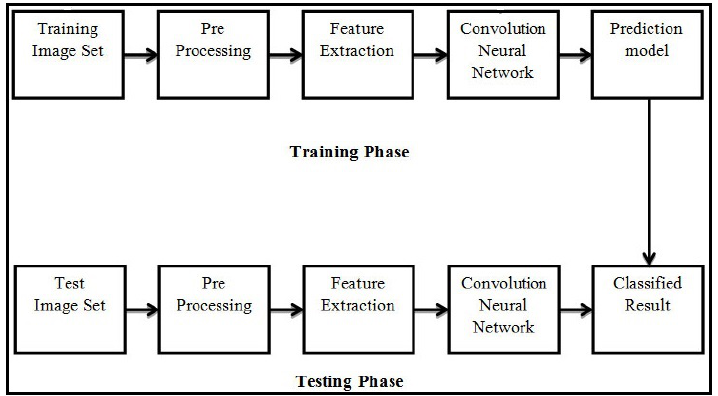
Figure 11. Block diagram of proposed Urdu handwritten character classification system.